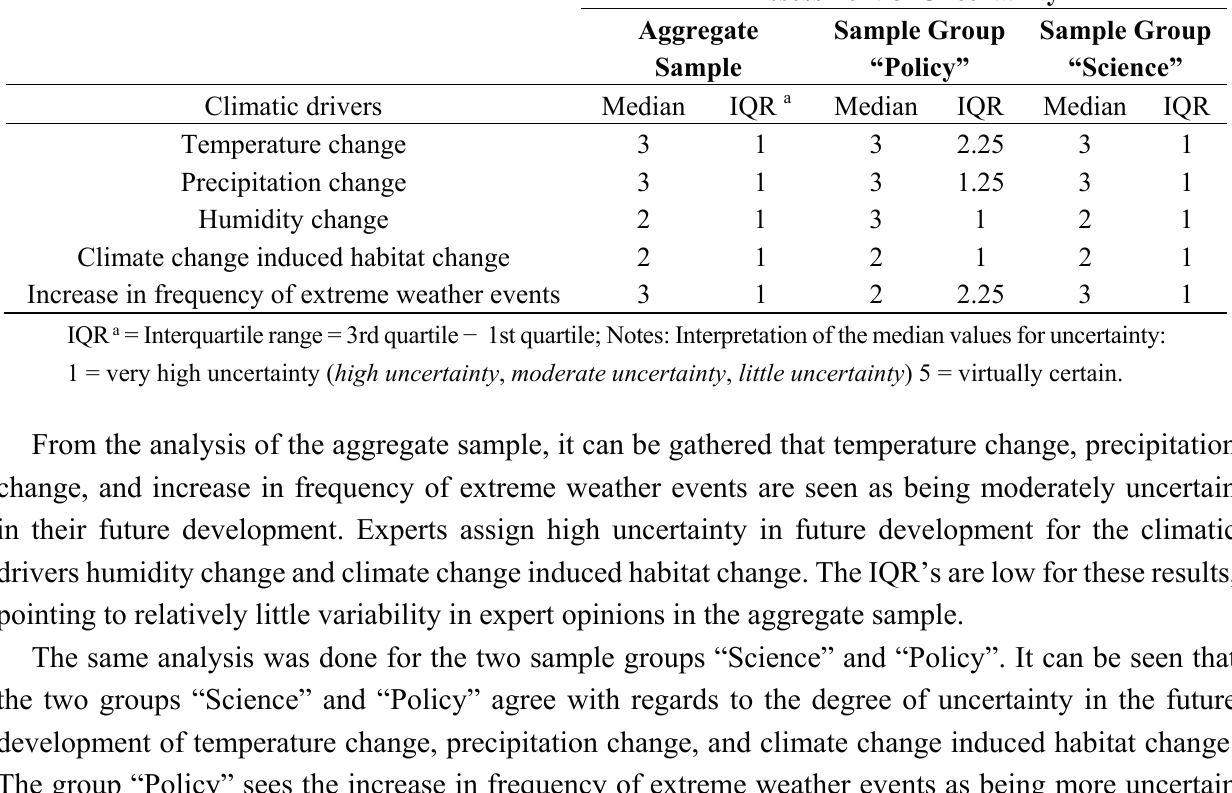
Table 1. Assessment results of the degree of uncertainty in the future development of each climatic driver, for the aggregate sample and the two sample groups “Policy” and “Science”. Assessment of Uncertainty